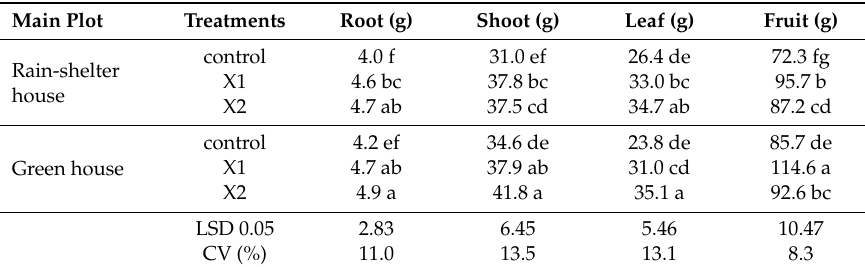
Table 3. Dry weights of root, shoot, leaf, and fruits at 70 DAT. Table 3. Cont.